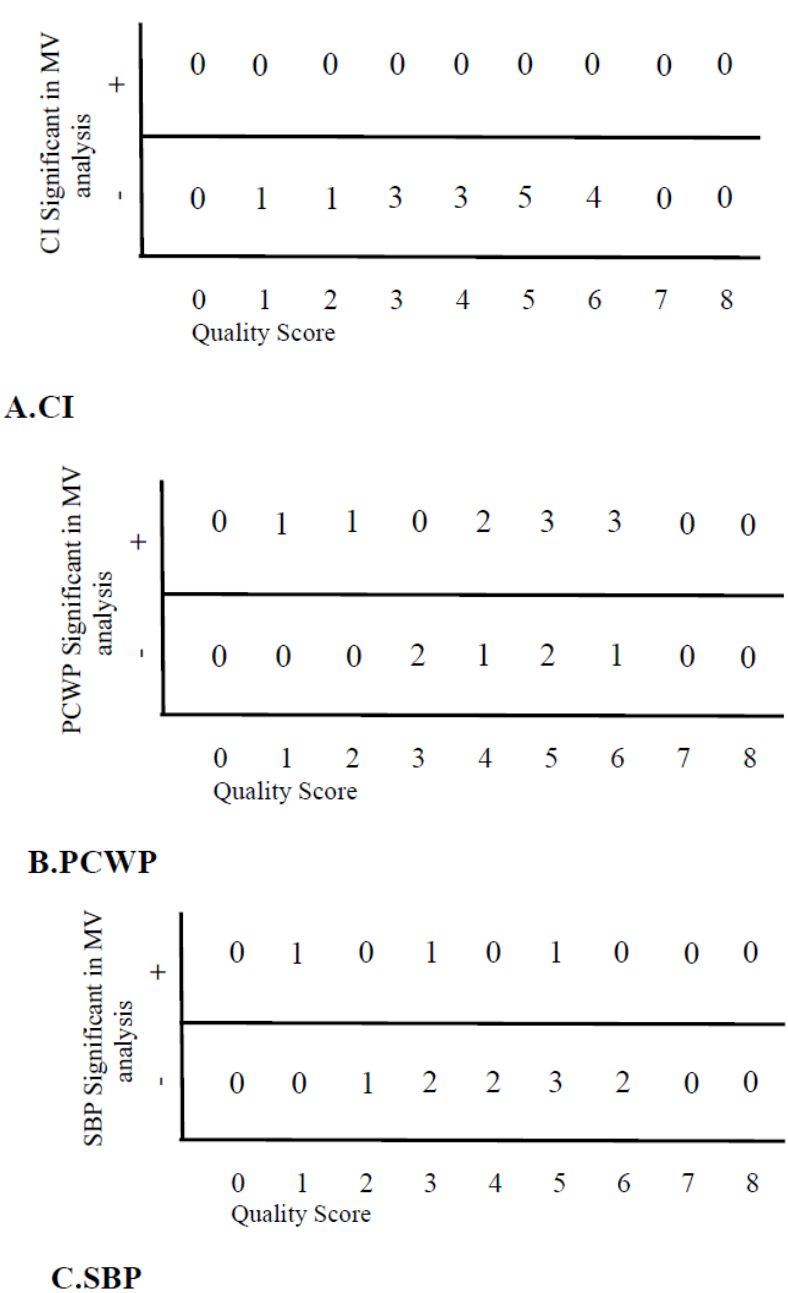
Figure 2. Prognostic significance of hemodynamic variables versus quality of the studies. Number of studies reporting significance for a hemodynamic variable in relation to the quality score of the studies. A for cardiac output/ index (CI), B for capillary wedge pressure (PCWP), C for systolic blood pressure (SBP).